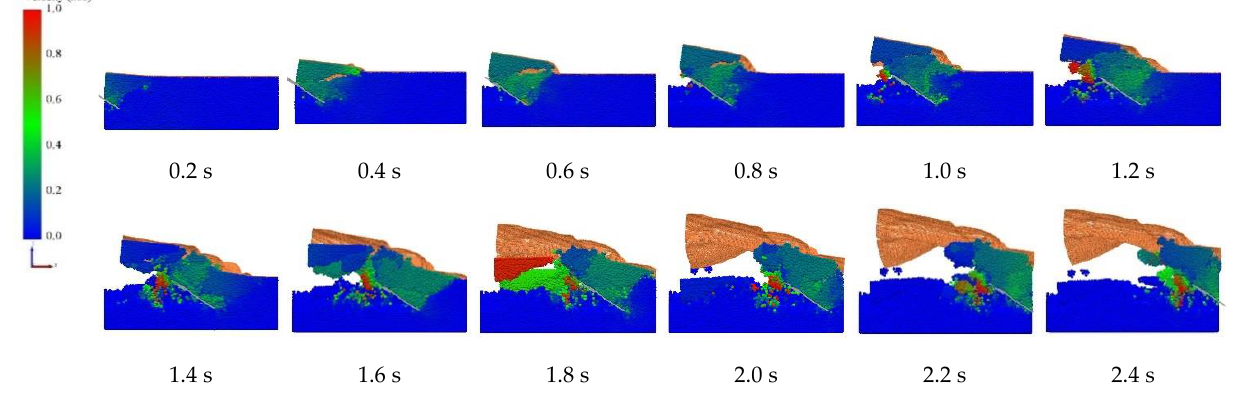
Figure 5. Soil disturbance and migration behaviors at different times under the action of the third- order shovel film-lifting parts.